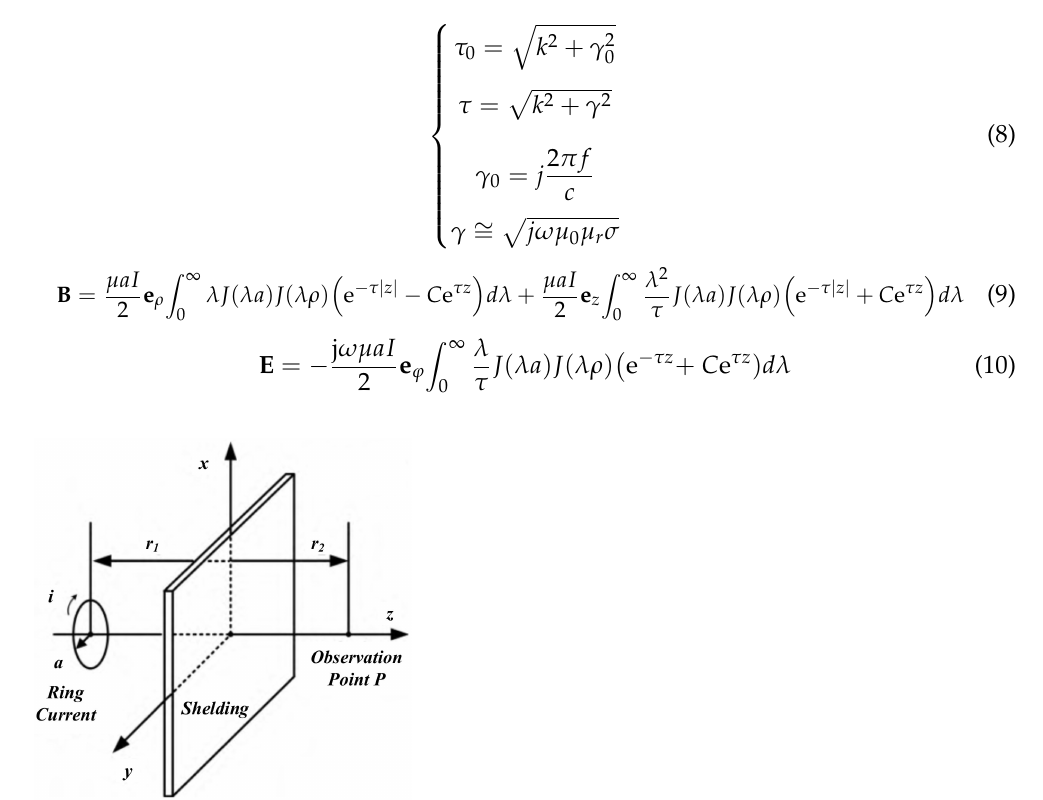
Figure 17. Electromagnetic shielding effectiveness analysis diagram of Moser’s